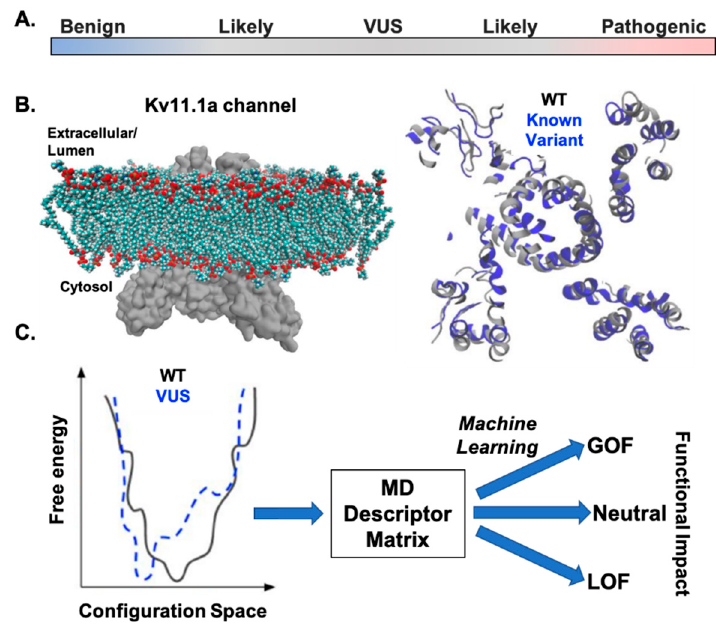
Figure 4. ( A ). The American College of Medical Genetics and Genomics and the Association of Molecular Pathology provides a rubric that can be used to classify variants identified in Mendelian-linked disease alleles as pathogenic, likely pathogenic, uncertain significance, likely benign, and benign. ( B ). Shown is an example of how molecular dynamics (MD)simulations could be used to determine the structural impactof known and newly identified variants on Kv11.1a channel configurations. ( C ). MD simulations could be used to relate structural configurations to thermodynamic changes, like those controlling folding, that cause a LOF, gain of function (GOF) or neutral phenotype. Such predictions could be compiled for known variants into a descriptor matrix to train machine learning approaches for de novo prediction of the structural and functional impact of newly identified VUS in Kv11.1a channels. Over time, the sensitivity of these approaches might be fine-tuned to determine which VUS act as genetic modifiers.